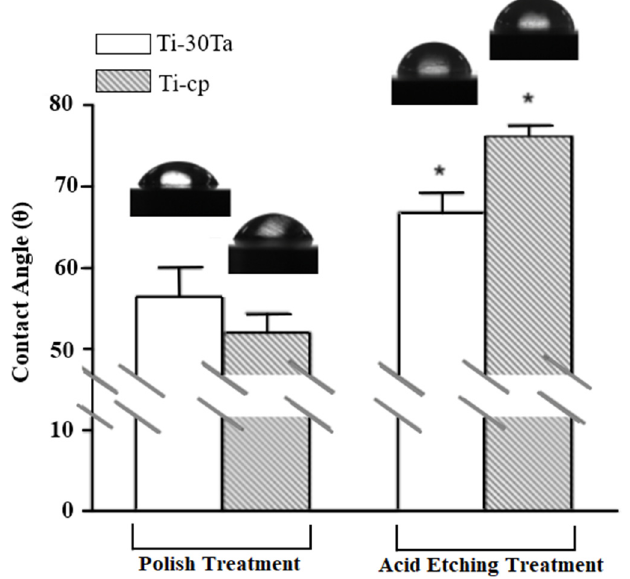
Figure 3. Water contact angle of cp-Ti and Ti-30Ta surface. * indicates that the difference between the samples are statistically significant ( p < 0.05). Table 5. Surface energy of the non-coated cp-Ti and Ti-30Ta